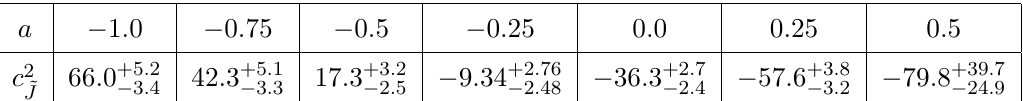
Table 4 . Extracted values of the two-loop jet function constants c 2 the value for c (2) implied by eq. (3.20) and the numerical results for r 2